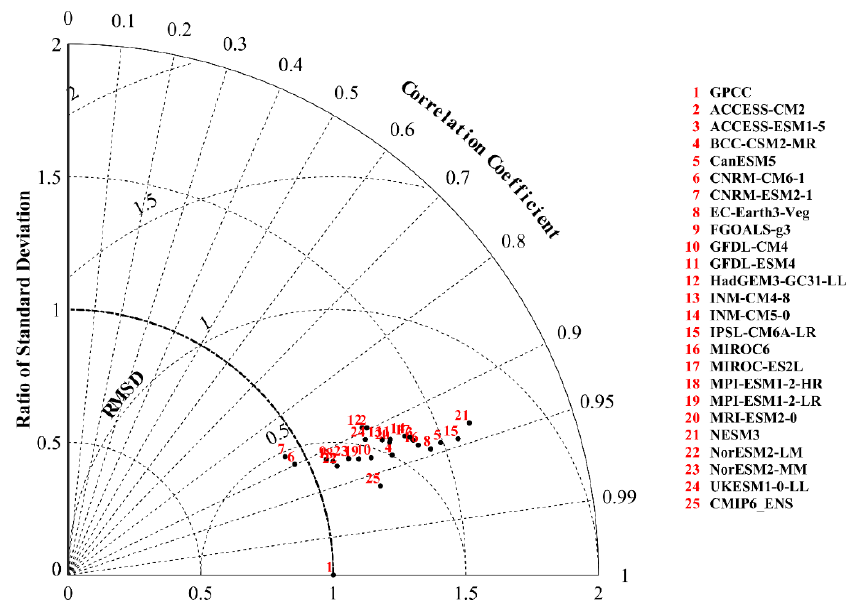
Figure 6. Taylor diagram evaluating monthly precipitation data from 1901 to 2014, relative to GPCC data. The angular axes are the correlation coefficient between model and observation; the radial axes are the ratio of standard deviation to that of the reference data. The concentric semi-circles are the root-mean-square difference. Each dot is a dataset with an identification number.